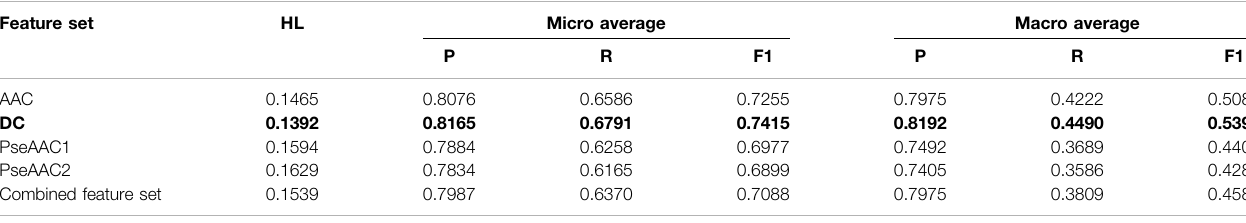
TABLE 2 | Training performance outcome for BR-RF classi fi er (Note that the best performing feature set is shown in bold). Feature set